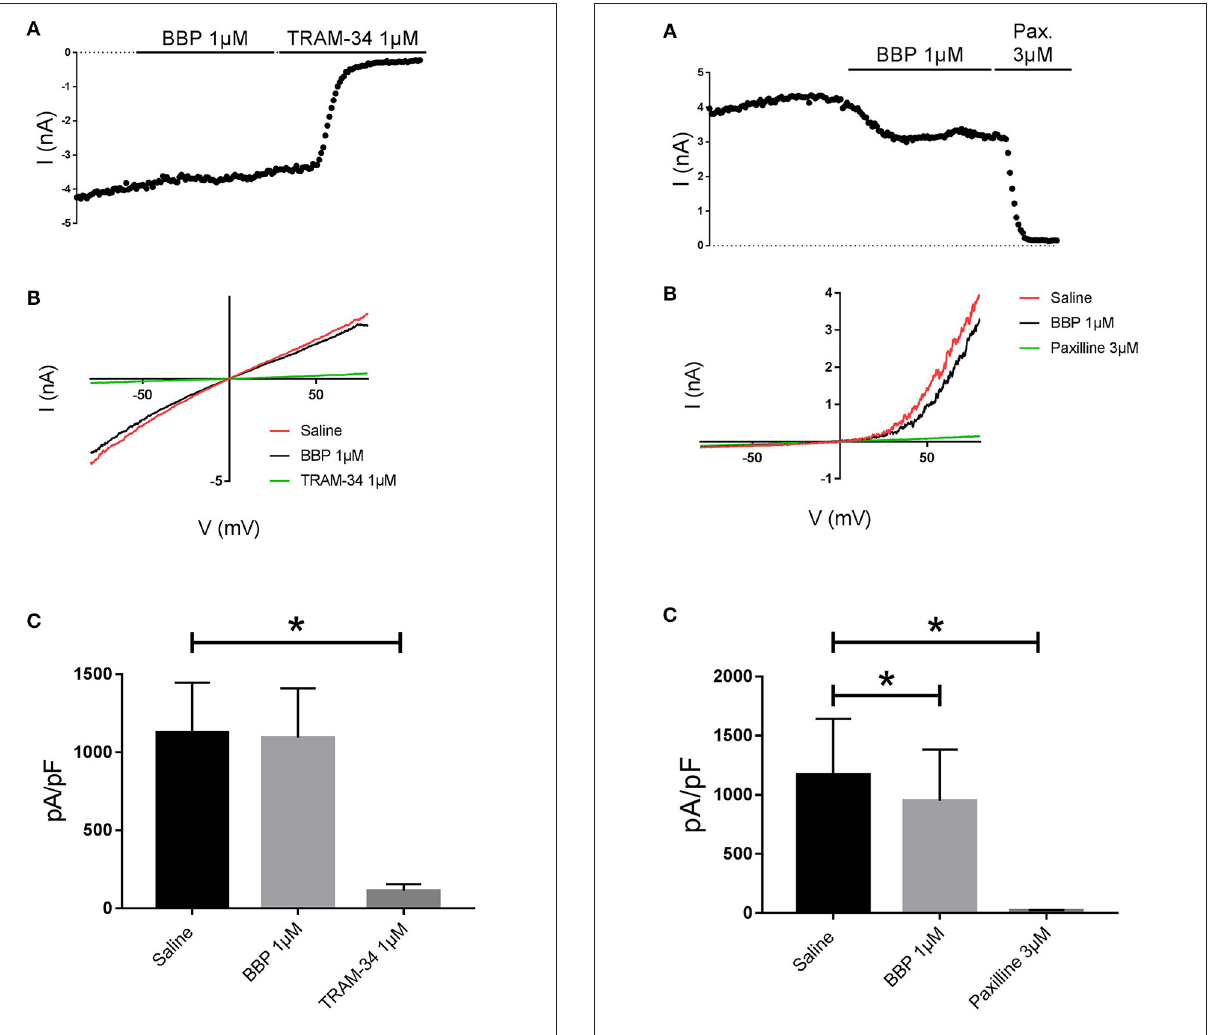
FIGURE 3 | Effect of BBP 1 µ M on hIK ( n = 6). Representative current-time plot (A) and its corresponding current-voltage plot (B) depicting the effect of BBP 1 µ M and the specific IK inhibitor TRAM-34 1 µ M. (C) , a column graph compares the effects of both BBP and TRAM-34 with the control current. IK current was not affected by BBP 1 µ M. * p < 0.05.